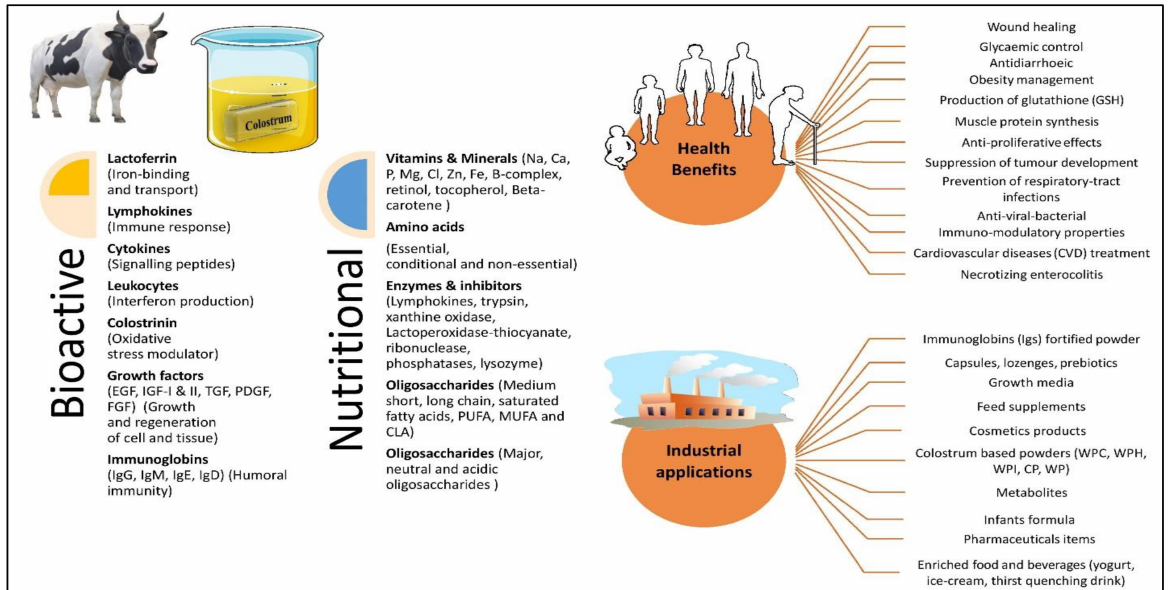
Figure 1. Overview of bovine colostrum nutritional and bioactive components with their medicinal and industrial